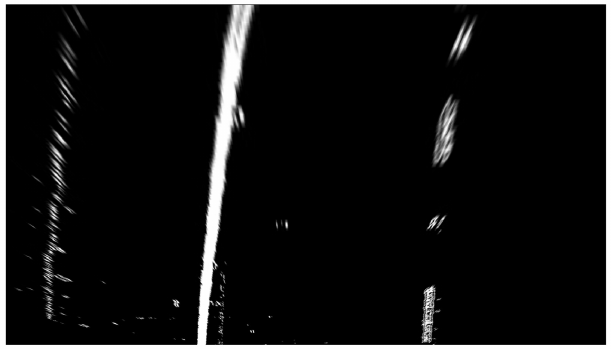
Figure 7. The aerial view of the lane.